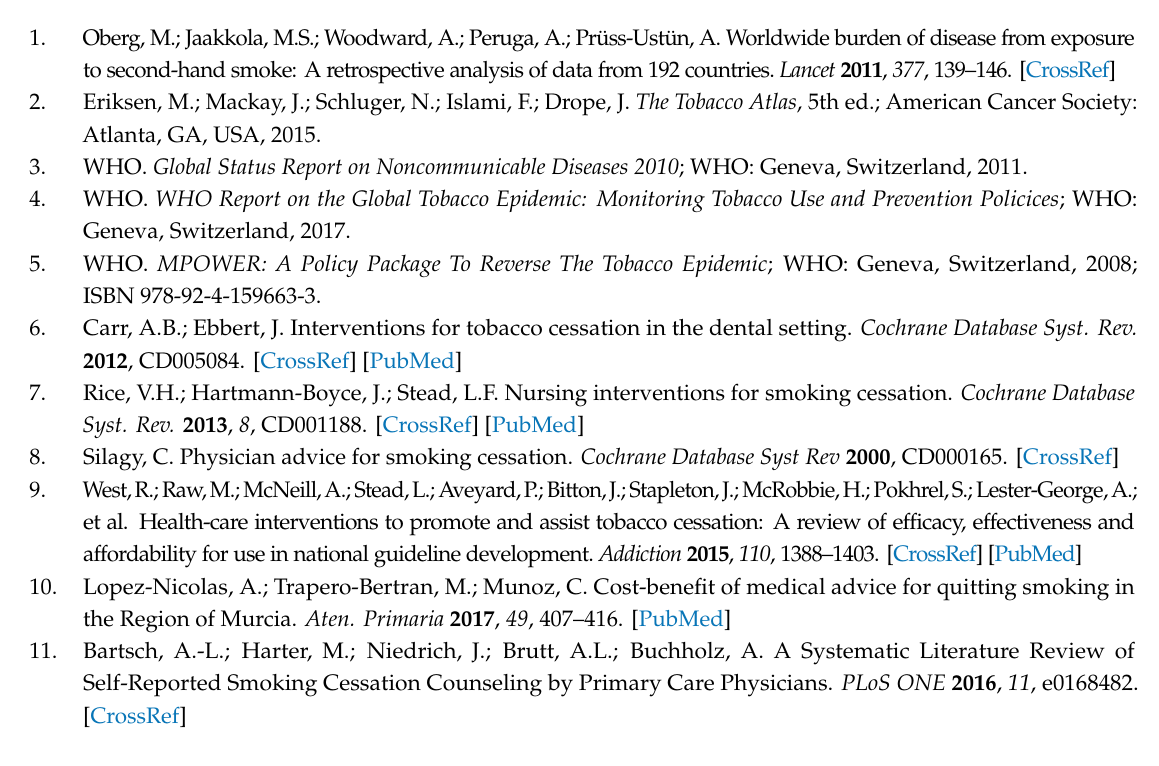
Figure S1: Brief Tobacco Intervention (BTI-St © ), Table S1: Comparison of instruments to measure anti-tobacco